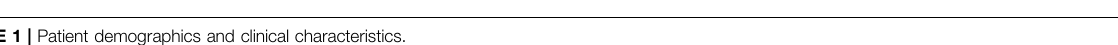
Δ CT value Group L (n = 59) Group H (n =